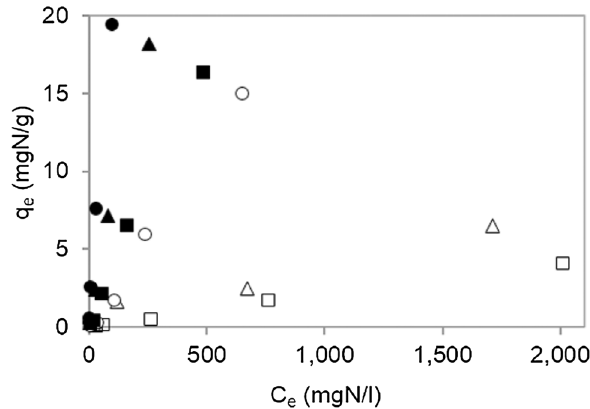
Fig. 2 Adsorption of ammonium 30–3000 mgN/l onto RH (open cir- cle), RHB (filled circle), C-RH (open square), C-RHB (filled square), S-RH (open triangle), and S-RHB (filled triangle) at 25 ± 1 °C, initial pH of 7.0 ± 0.5